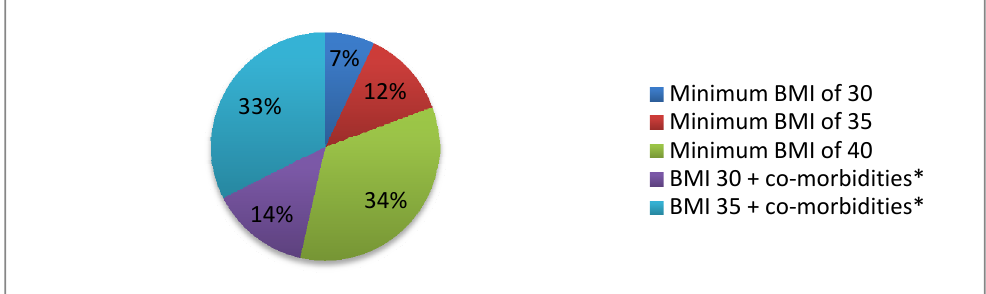
Figure 3. Minimum body mass index (BMI) for adolescent bariatric surgery; overall